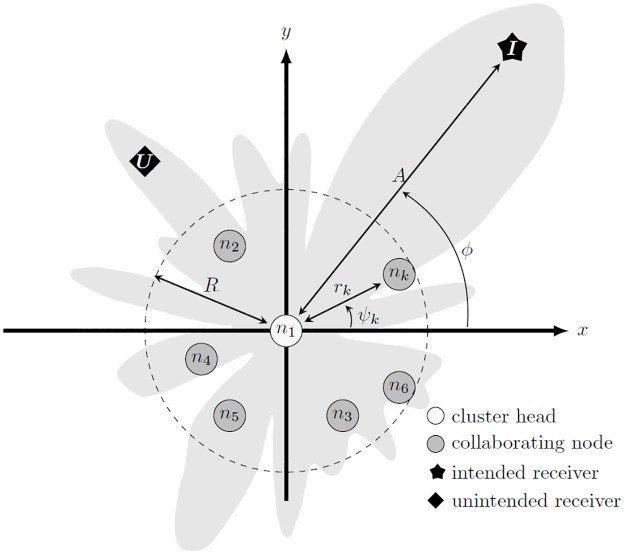
Geometrical model of collaborative beamforming [23].